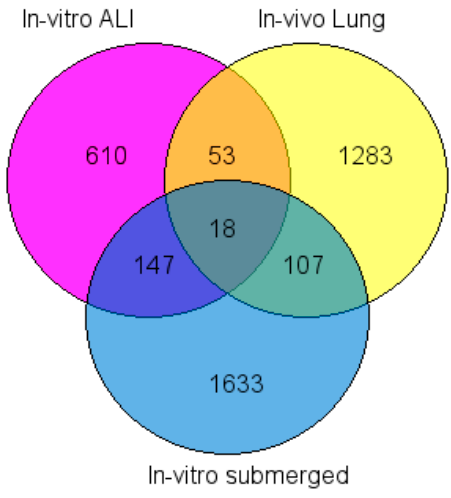
Figure 4. Venn diagram of differentially deregulated genes after TiO 2 NP in vivo (lung), in vitro submerged and ALI (Vitrocell) exposures (FDR corrected p -value < 0.05). Genes were filtered with different fold change cutoff: In vitro submerged: 2.8, In vitro ALI Vitrocell: 1.3 and In vivo lung: 1.3. 2.5. Comparison of Functional Annotations of Dysregulated Genes In Vivo, In Vitro, and ALI after Exposition to TiO 2 NP